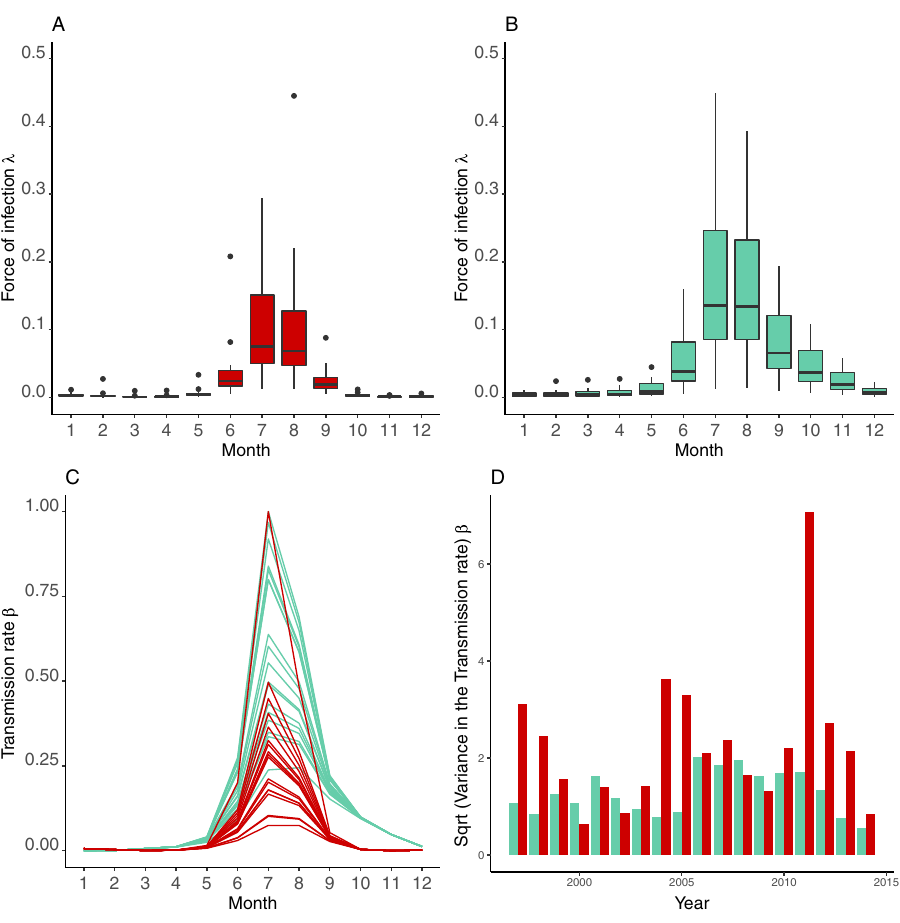
Fig. 3 Estimated transmission rate and force of infection in the two cities. Monthly average force of infection and transmission rate from one representative simulation for the period 1997 – 2014 in Ahmedabad (red, A , C , D ) and in Surat (green, B , C , D ). The respective box plots of the force of infection by month per city are shown in ( A ) and ( B ) (computed for n = 1000 simulations and with the standard illustration of the minimum, 25th percentile, median, 75th percentile, and maximum). The force of infection equals the transmission rate ( β ) times the number of infected individuals and therefore measures the per capita rate at which susceptible (non-immune) individuals become infected. C The corresponding monthly transmission rate for each year for Ahmedabad (in red) and Surat (in green), which includes in the model the effect of humidity. D The corresponding variance in the force of infection is calculated within each year.